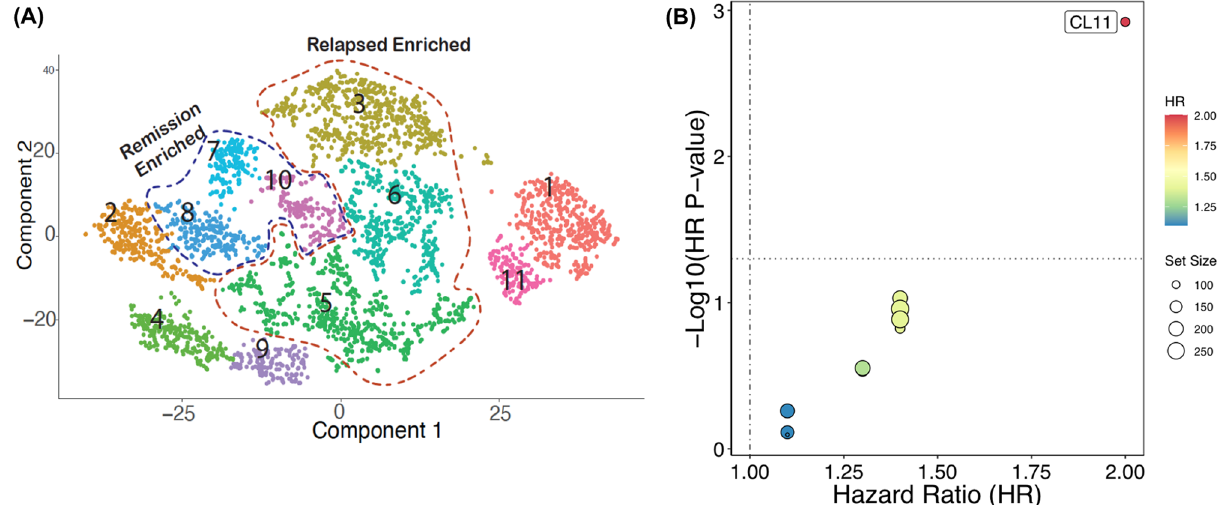
Figure 7. Single-cell clusters-based survival analysis. ( A ) UMAP of single-cell RNA-seq data from relapse- associated non-AML cells at the time of diagnosis. The colors represent the 11 distinct sub-clusters of T cells. ( B ) Prognostic significance of identified scRNA-seq clusters on overall survival in TCGA-LAML patient dataset. The significant associations between cluster enrichment and OS are clusters (Fig. 7A) generated from scRNA-seq analysis of paired pediatric AML bone marrow samples taken at the time of diagnosis and end of induction 27 . We performed Cox proportional survival analysis using TCGA-LAML dataset (Fig. 7). Out of the 11 T cell clusters, the relapse-associated cluster (#CL11) depicted a significant associa- tion with poor survival (HR = 2, p -value = 0.001) (Fig. 7B). Moreover, cluster 11 (#CL11) depicted overexpres- sion of CD69, a type II glycoprotein that is known to regulate inflammation and exhaustion of tissue-resident T cells and promote tumor growth/relapse 28 .